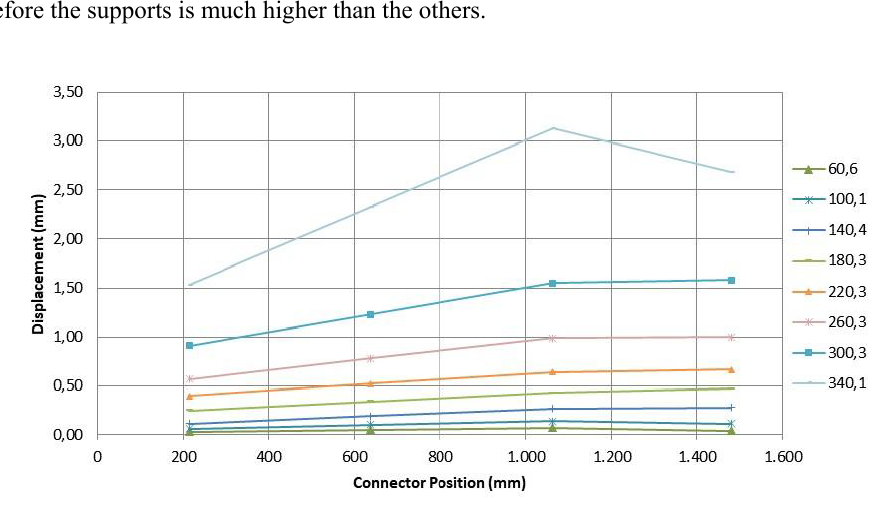
Figure 23. Relative displacement –